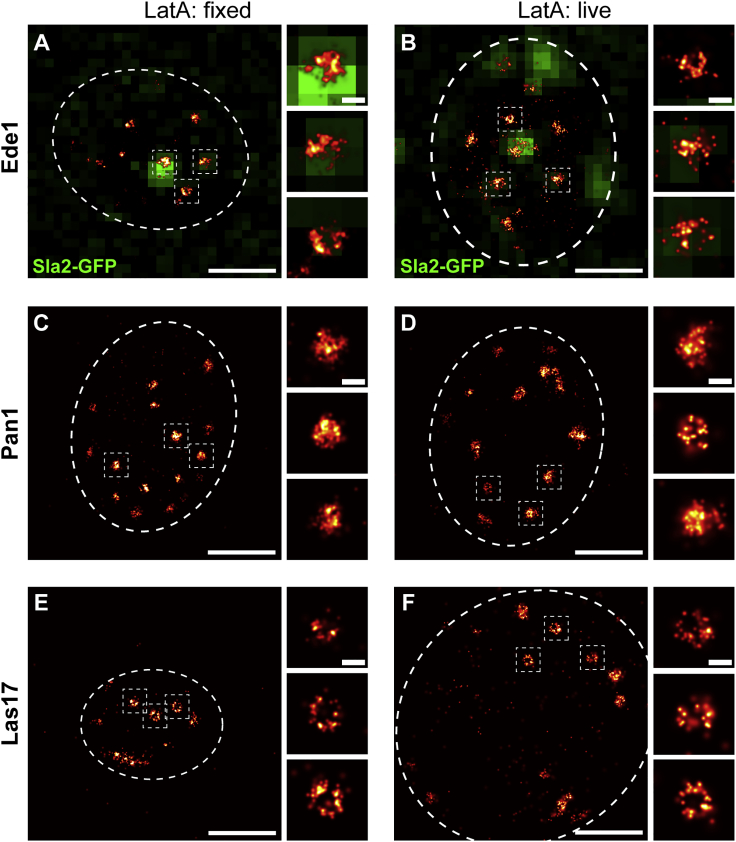
Ede1, Pan1, and Las17 Structures after Latrunculin A Treatment, Related to Figure 2H(A–F) Shown are images of fixed (A, C, and E) and living (B, D, and F) cells, where endocytic sites have been arrested on flat membranes using Latrunculin A. (A and B) Show cells expressing Ede1-mMaple and Sla2-GFP.(C and D) Show cells expressing Pan1-mMaple and Abp1-GFP. The signal from Abp1-GFP was diffuse due to LatA treatment and omitted here. (E and F) Show cells expressing Las17-mMaple and Abp1-GFP. The signal from Abp1-GFP was diffuse due to LatA treatment and omitted here. Boxed regions have been magnified. Scale bars are 1 μm and 100 nm (zoomed regions).